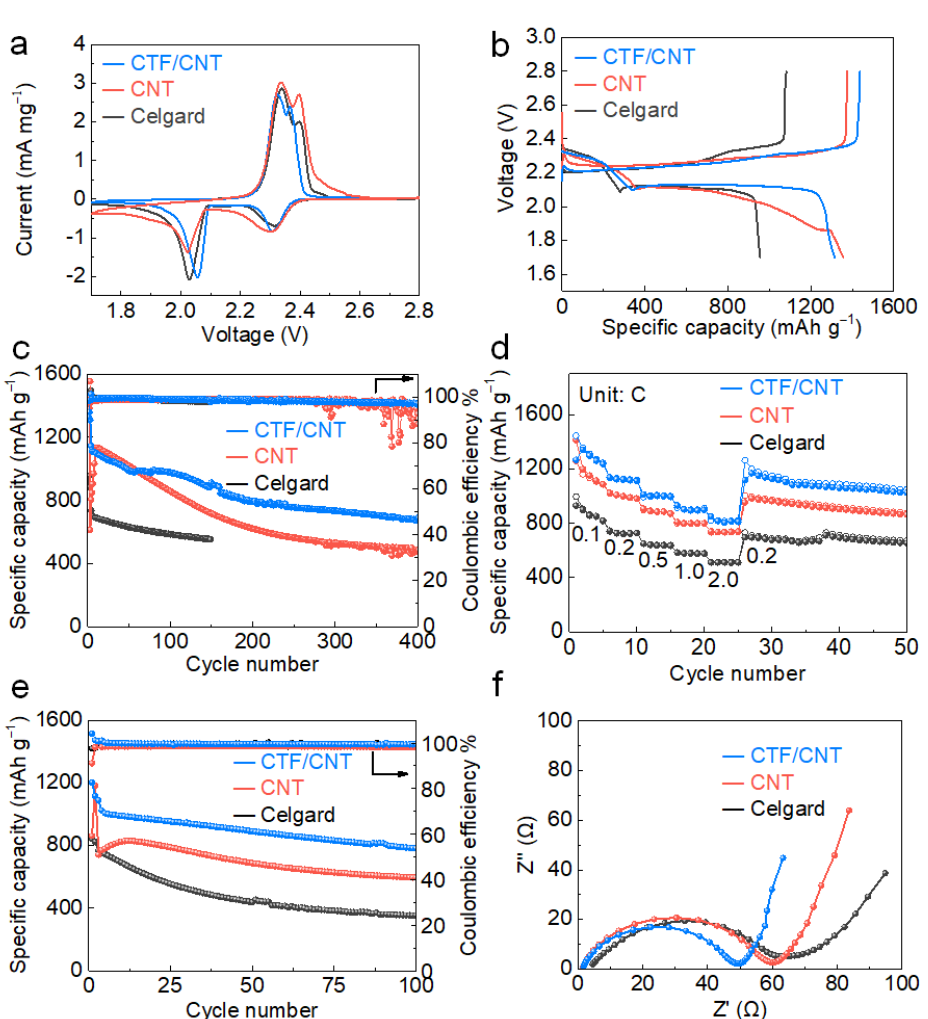
Figure 4. Electrochemical performances of Li–S cells with different separators: ( a ) CV curves at 0.1 mV s − 1 , ( b ) initial galvanostatic discharge–charge profiles at 0.1 C, ( c ) cycling performance at 1 C, and ( d ) rate performance, ( e ) cycling stability of Li–S cells with a high mass loading of sulfur (2 mg cm − 2 ) at 0.5 C, and ( f ) EIS plots after electrochemical cycling.